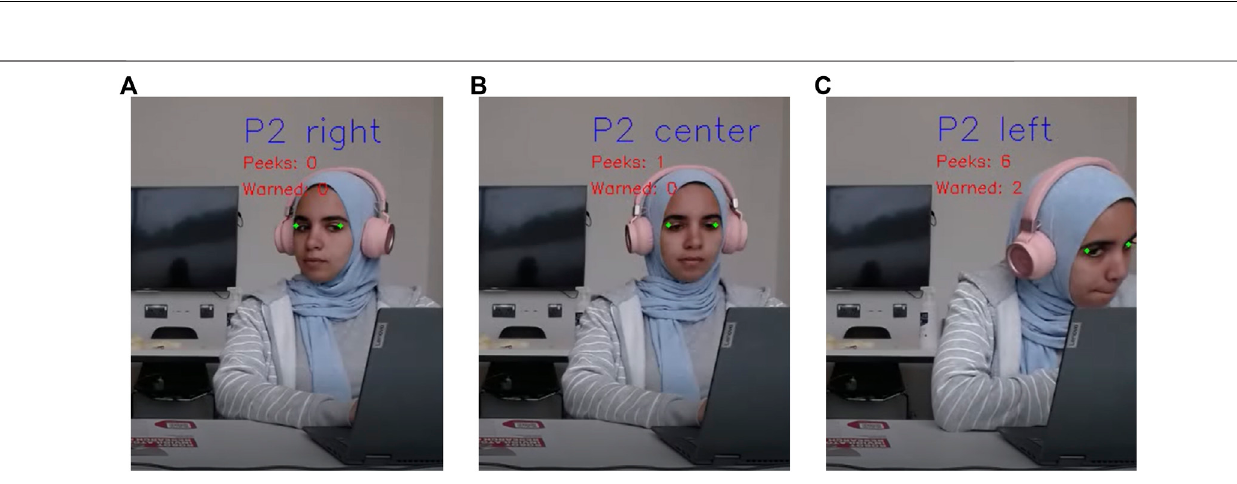
Frontiers in Robotics and AI |